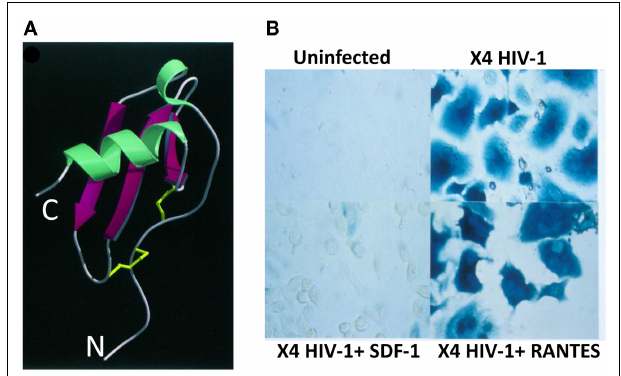
FIGURE 1 | Structure and mode of action of CXCL12/SDF-1 in HIV-1 infection . (A) Ribbon structure of human CXCL12/SDF-1 α . The two disulfur bonds are indicated in yellow (9). N, amino-terminus; C, carboxy-terminus. (B) Human cells expressing CD4 and CXCR4 infected or not with an X4 HIV-1 isolate in the presence of SDF-1/CXCL12 or RANTES/CCL5. Infected cells are visualized by β -galactosidase